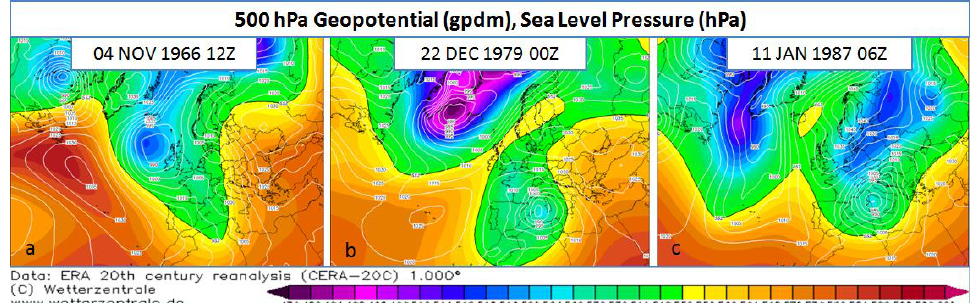
Figure 4. Sea level pressure maps from 4 November 1966 ( a ), 23 December 1979 ( b ), and 11 January 1987 ( c ). In all cases, a deep Mediterranean low, centered around Sardinia, is active with relevant horizontal barometric gradients on Italy and surrounding seas, triggering strong southerly winds (ERA-20C–1.000° (European Atmospheric Reanalysis of the 20 century). Maps downloaded by www.wetterzentrale.de, accessed on 6 September 2021.